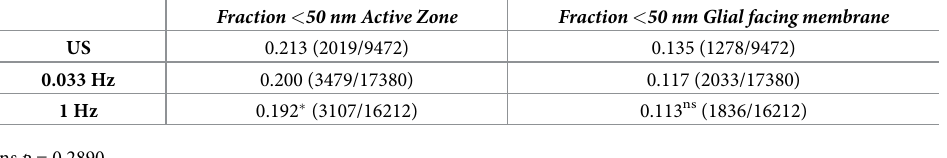
Table 2. Contingency table of vesicle distances from presynaptic membrane. Data are expressed as number of vesi- cles less than 50 nm from the membrane / total number, and were analysed using two-sided Fisher’s exact tests to com- pare vesicle distribution between 0.033 Hz and 1 Hz